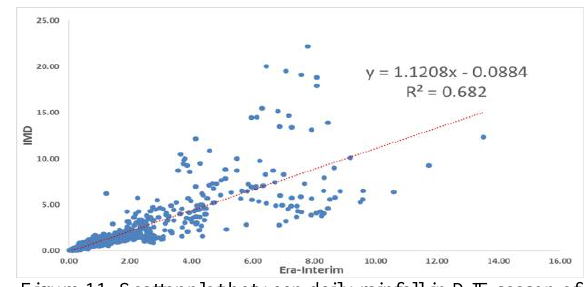
Figure 11. Scatter plot between daily rainfall in DJF season of Era-Interim and IMD rainfall products